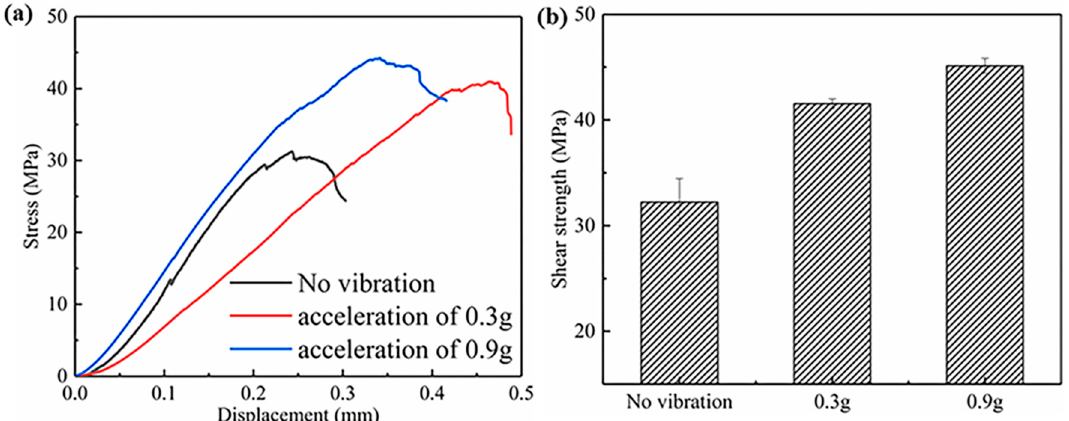
Figure 9. ( a ) Stress-displacement curves of the Mg–Al bimetals with different conditions; ( b ) Shear strengths of Mg–Al bimetals with different conditions.